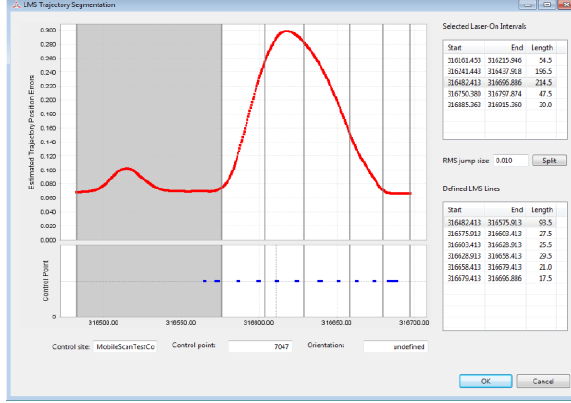
Figure 3. Trajectory segmentation based on GNSS position quality.